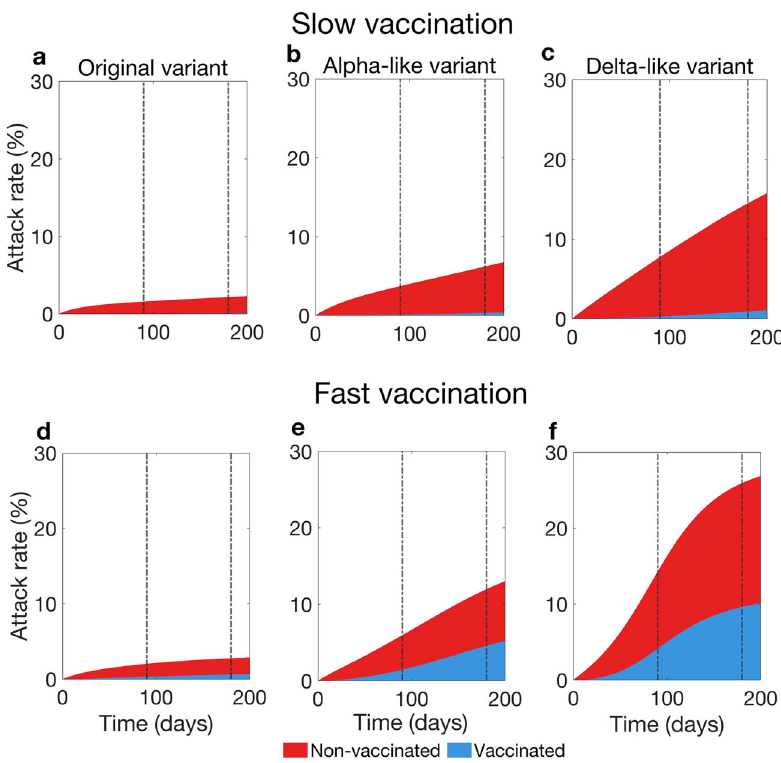
Fig. 4 Contribution of vaccinated and non-vaccinated individuals to attack rate during the vaccination rollout. We consider the scenario with low vaccine ef fi cacy in conferring immunity against acquisition of infection (60%). a – c show attack rates versus time given the slow vaccine uptake rate. d , e , and f show attack rates versus time given the fast vaccine uptake rate. a and d show these quantities for the original variant, b and e for an Alpha-like variant, c and f for a Delta-like variant. Vertical brown lines mark three and 6 months since the start of the vaccination campaign. Attack rate is the proportion of the population that has been infected until a given time. We adjusted the attack rate so that it describes only new infections that appeared during the time interval that we